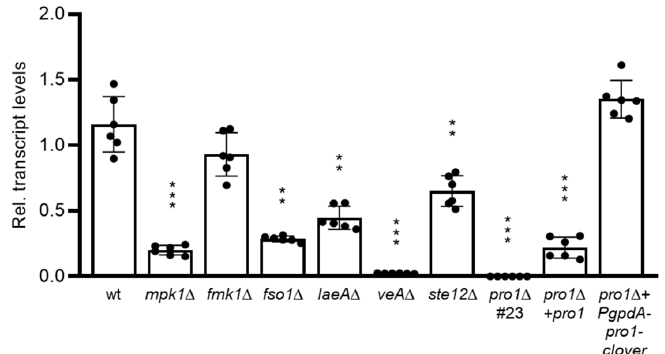
Figure 1. Transcriptional analysis of pro1 in different F. oxysporum strains. Quantitative real-time RT-PCR analysis was performed in the indicated strains germinated for 10 h in Puhalla minimal medium supplemented with 25 mM sodium glutamate and 20 mM 4-(2-hydroxyethyl)-1- piperazineethanesulfonic acid and adjusted to pH 7.4. Transcript levels of the pro1 gene are expressed relative to those of the wild type strain (wt). Data show means ± s.d. **, p < 0.001; ***, p < 0.0001 versus wt according to t test with Welch’s